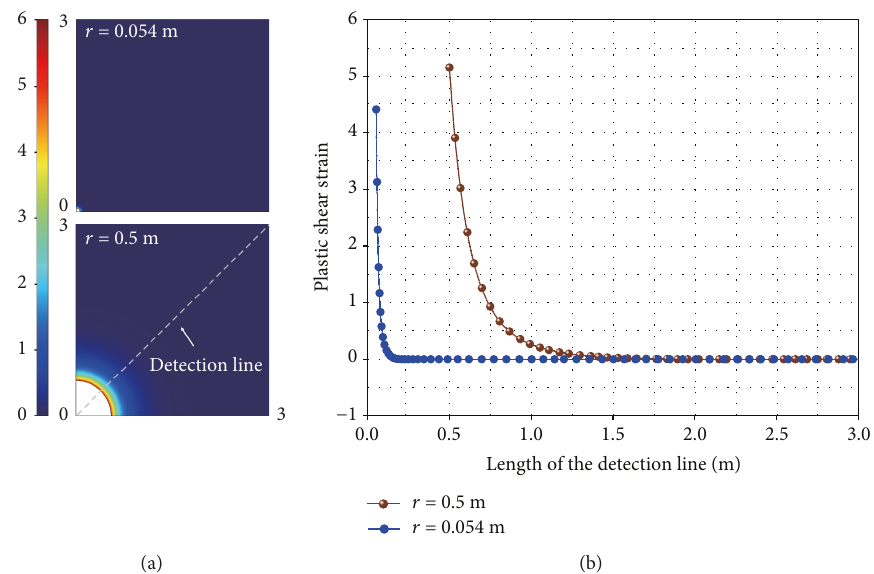
Figure 6: Damage variable distribution characteristics around a borehole.